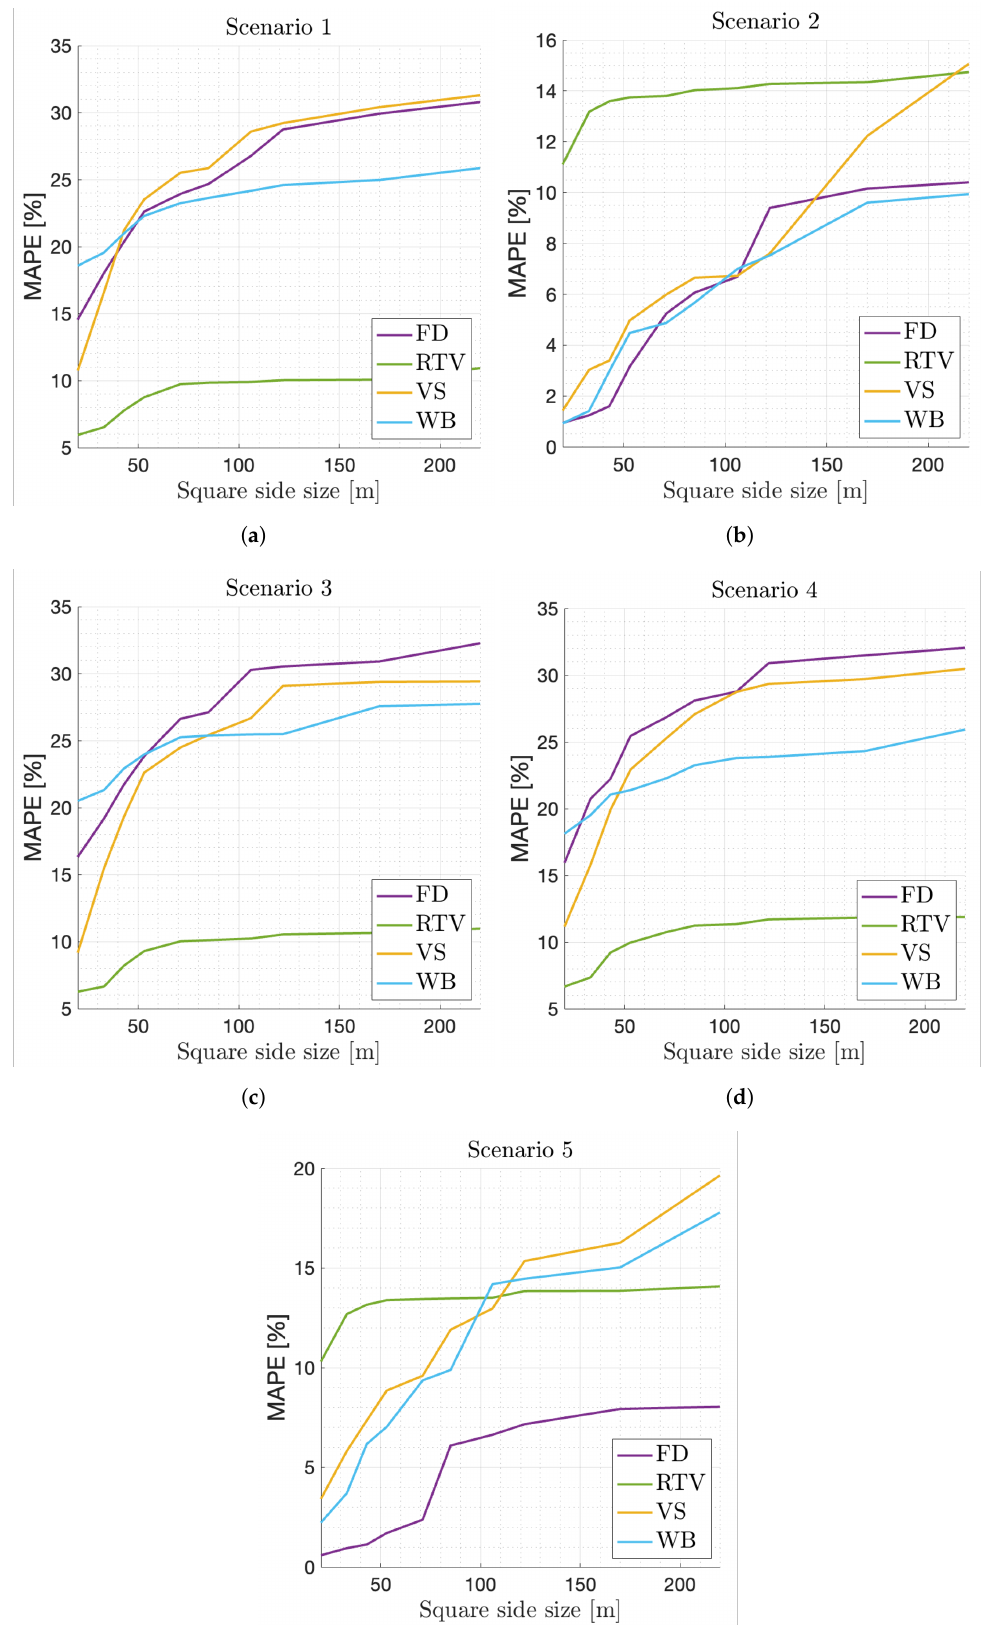
Figure 4. MAPE for different square side sizes, services and scenarios. ( a ) MAPE in Scenario 1. ( b ) MAPE in Scenario 2. ( c ) MAPE in Scenario 3. ( d ) MAPE in Scenario 4. ( e ) MAPE in Scenario